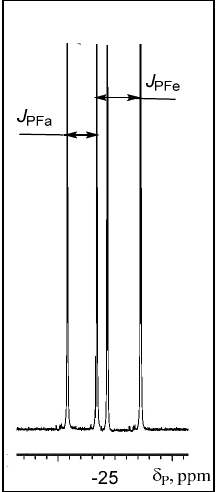
Figure 1. 31 P-NMR spectrum of 2-(diethylamino)-2,2-difluoro-4-tolyl-3-propyl-4-(trifluorophenyl- 1,2 λ 5 -oxaphosphetane 31 (See Table 2, entry 15).